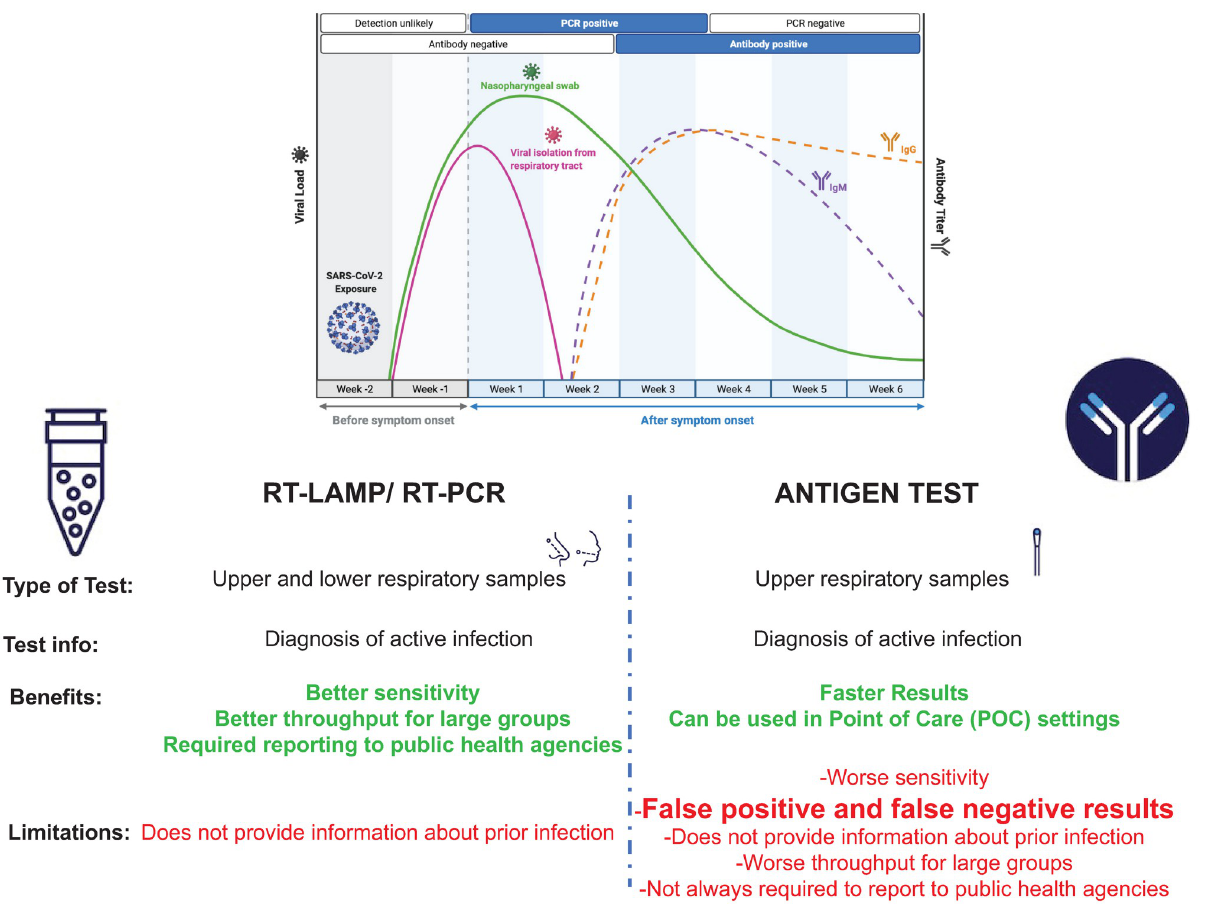
Fig 2. Comparison of RT-LAMP/PCR versus antigen tests for the detection of SARS-CoV-2.